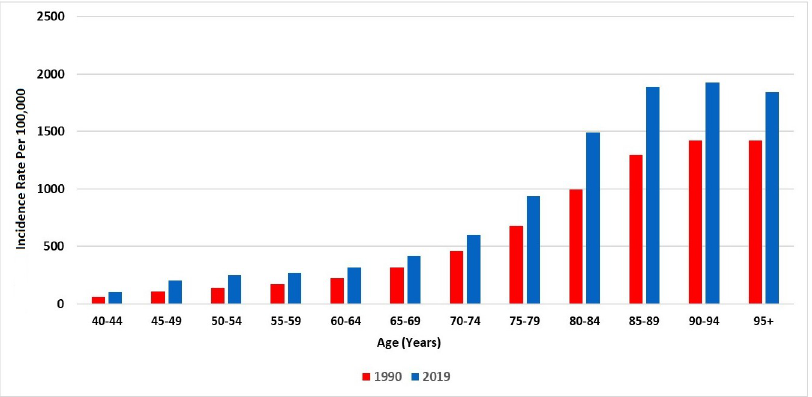
Fig 4. The incidence rate of COPD in Saudi Arabia (1990 and 2019), stratified by age.